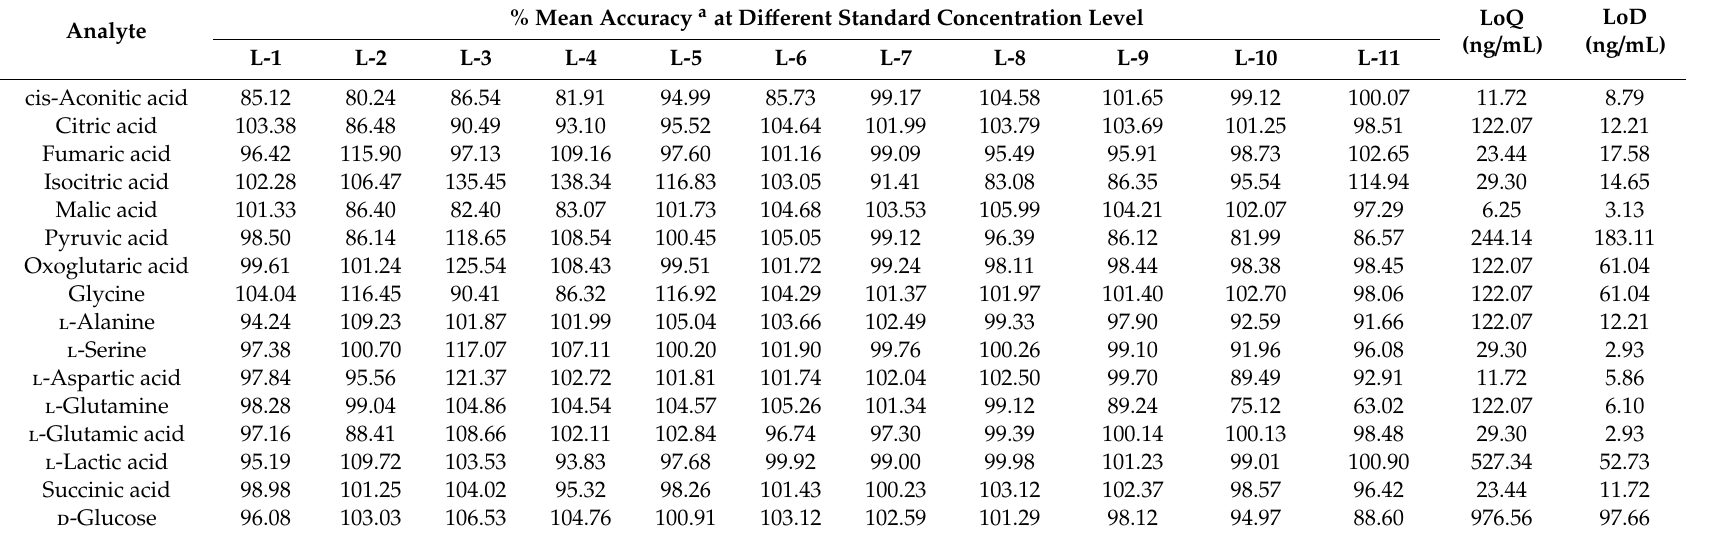
Table 1. Accuracy, limit of detection (LOD) and limit of quantification (LOQ) results of TCA cycle